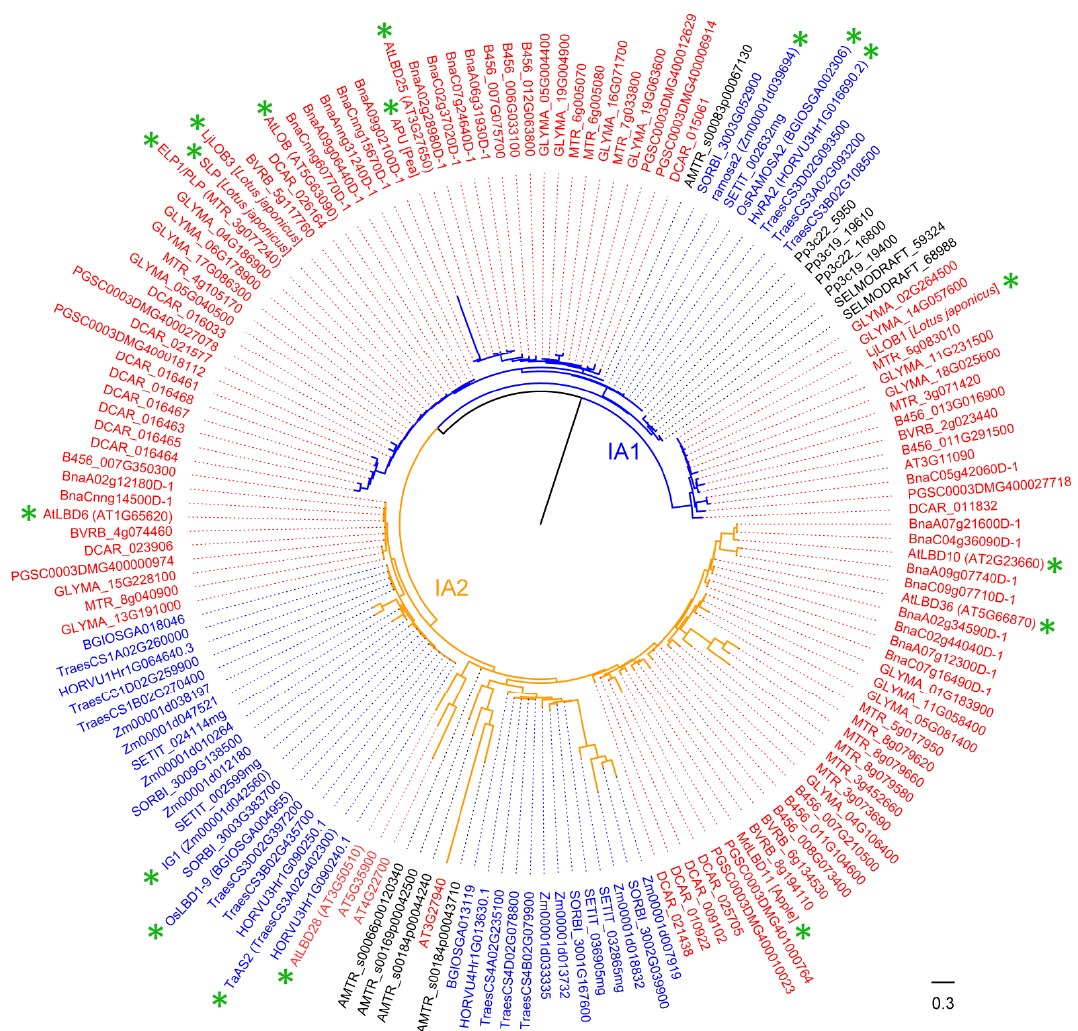
Figure 3. Phylogeny of LBD proteins from Class IA in 18 species. This phylogeny was reconstructed using Class IA LBD proteins identified in Figure 1 and according to the same method described in Figure 1 legend. “*” means functionally characterized LBD protein in Table 2 (Gene ID is in brackets for LBD proteins of 18 species, species name is in square brackets for LBD proteins of other species). LBD proteins of eudicots, monocots, and other plant species are marked in red, blue and black, respectively. Branch color corresponds to that in Figure 1.